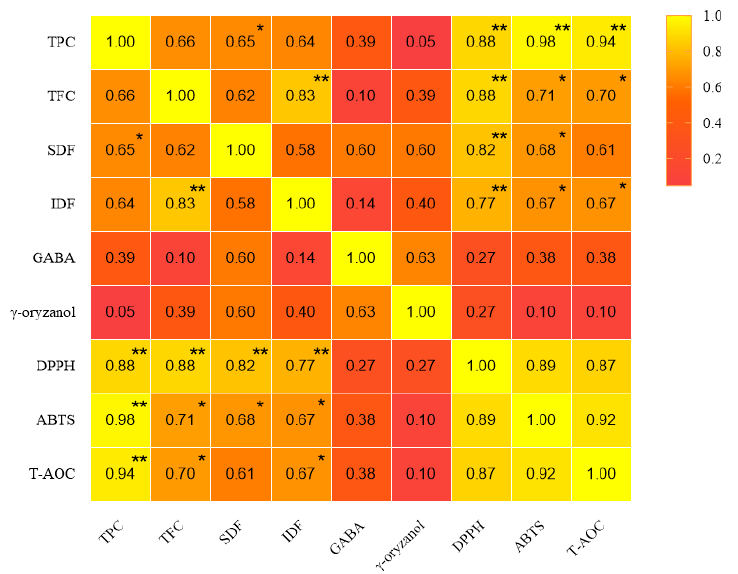
Figure 2. Correlation between the contents of bioactive substances and antioxidant activity of different brown rice products ( n = 3). * p < 0.05, ** p < 0.01, ns = not significant.